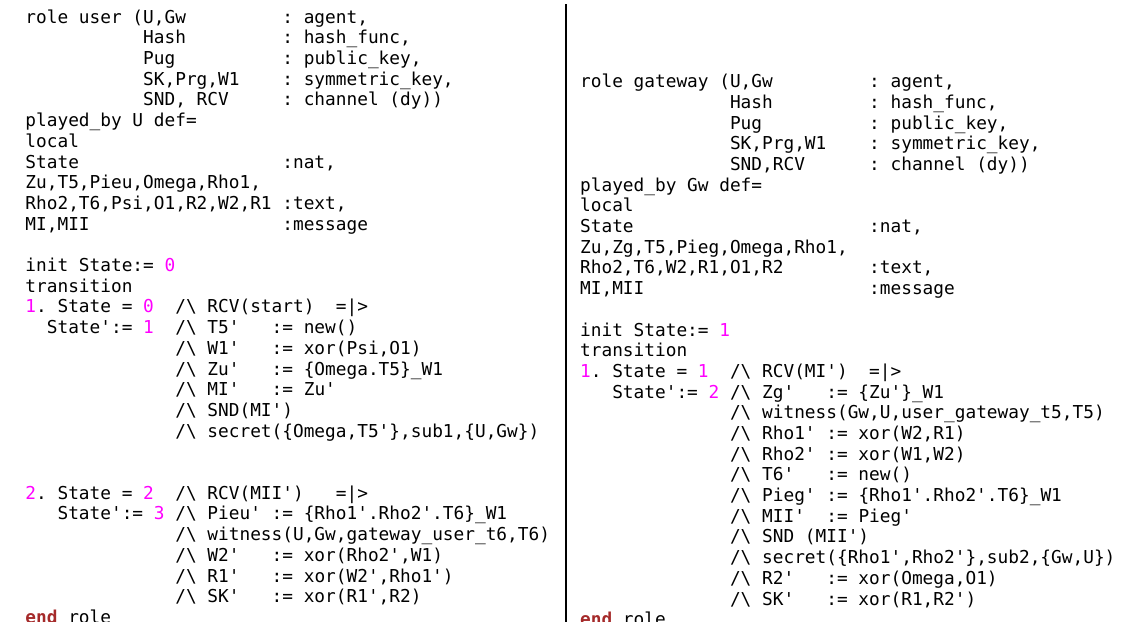
Figure 6. AVISPA Role Specification of the User and Gateway for our proposed MAKE-IT